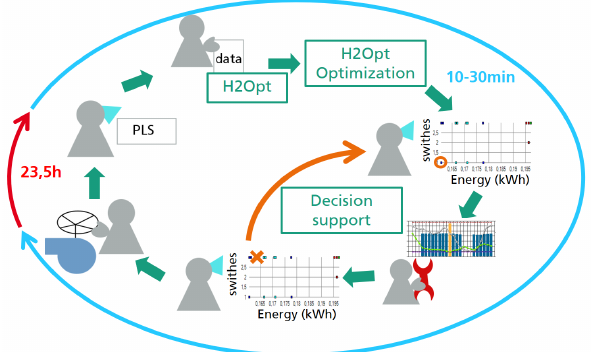
Figure 3. Daily workflow of the operator using the decision supporting software